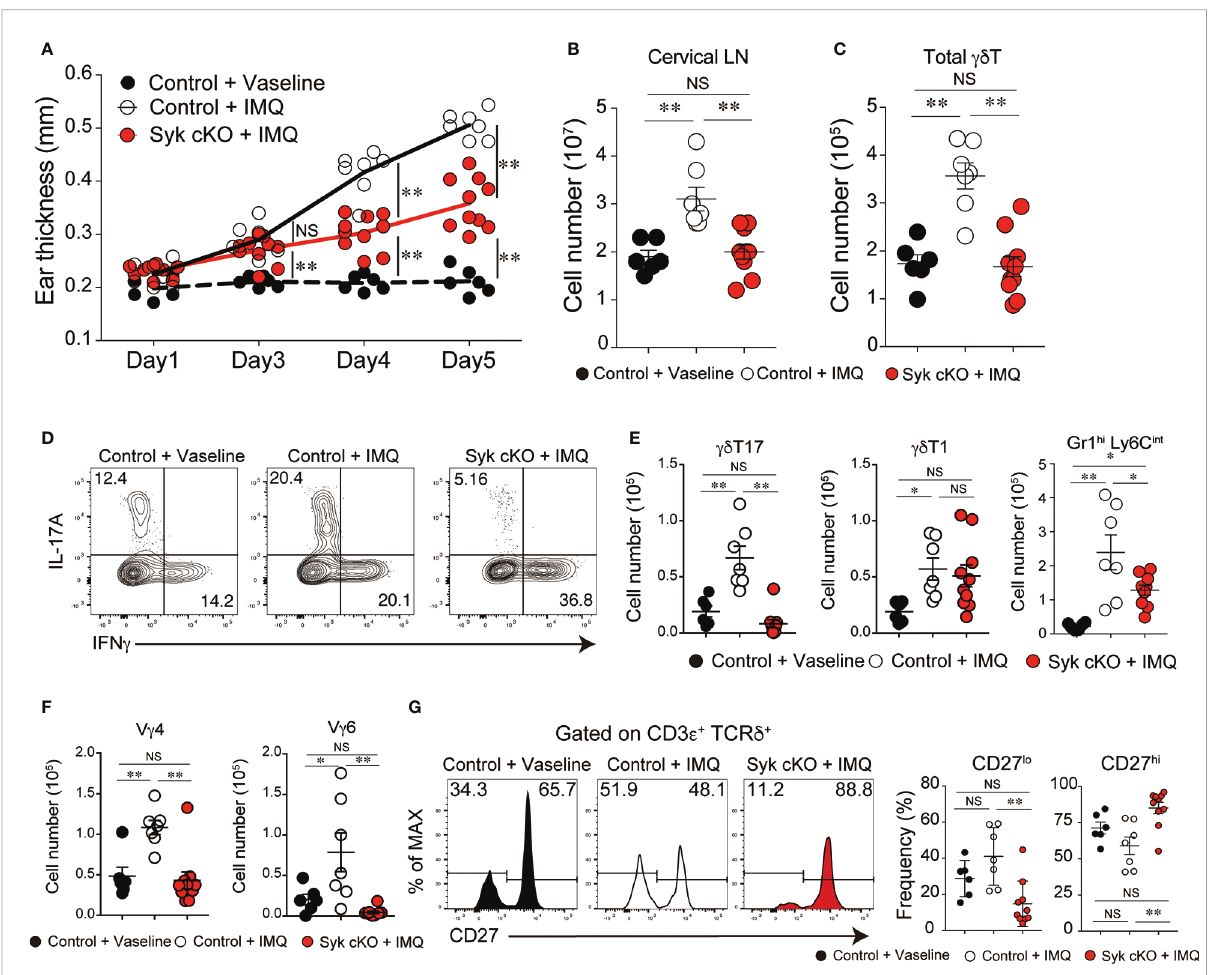
FIGURE 4 Amelioration of imiquimod (IMQ)-inducible dermatitis in Syk-cKO mice. Control (Cd127-cre Syk fl ox/wt) and Syk-cKO (Cd127-cre Syk fl ox/ fl ox) mice were treated daily for 5 days with IMQ or Vaseline applied onto the ear. On day 5, the cervical lymph node (cLN) was isolated and analyzed. (A – C) The kinetics of ear swelling (A) , the number of total cLN cells (B) and the number of gd T cells in the cLN (C) are shown. (D) Intracellular staining of IL-17A and IFN g for gd T cells in the cLN from mice shown in (A – C) . (E) The number of gd T17, gd T1 and Gr1 + CD11b + cells in the cLN. (F) The number of V g 4 + and V g 6 + gd T cells in the cLN. (G) Flow cytometric pro fi les of CD27 expression in total gd T cells from indicated mice. Graphs show the frequency of CD27 lo or CD27 hi gd T cells. Data were obtained from 6 to 10 mice in each group from